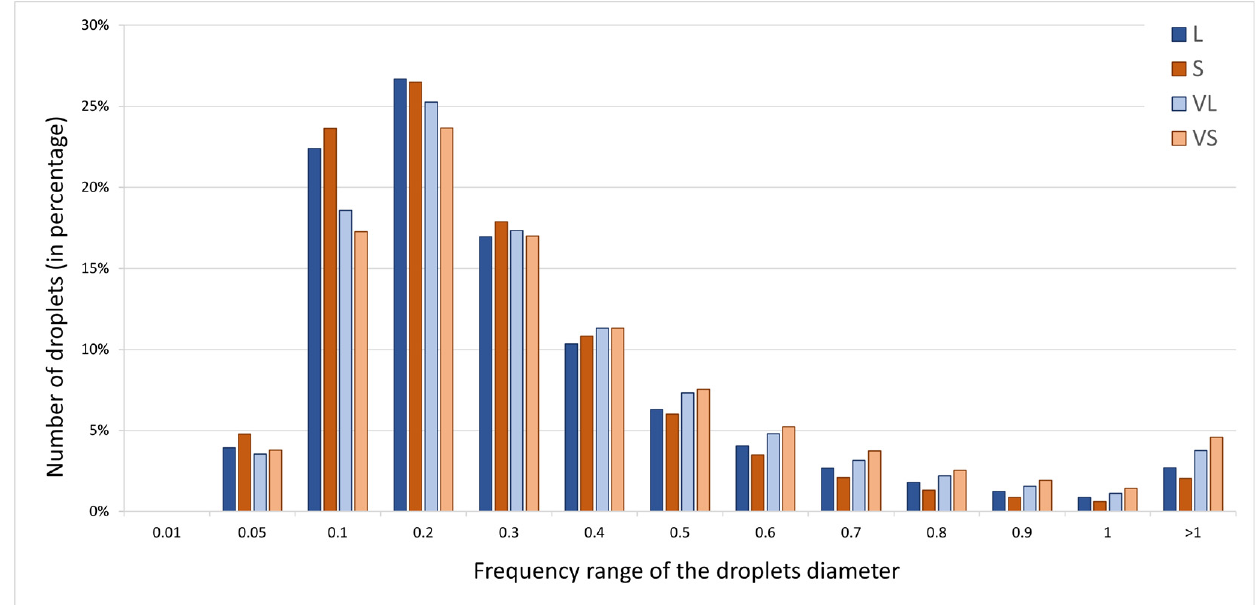
Figure 11. Frequency plot describing the number of droplets (in percentage) for each diameter range.